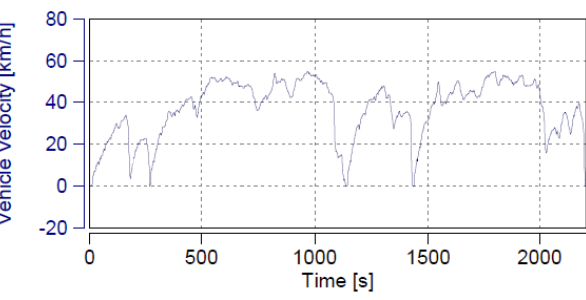
Fig. 4. Road test velocity profile of the vehicle The concentrations of the selected exhaust components in the road test were recorded and presented in a graphical form.